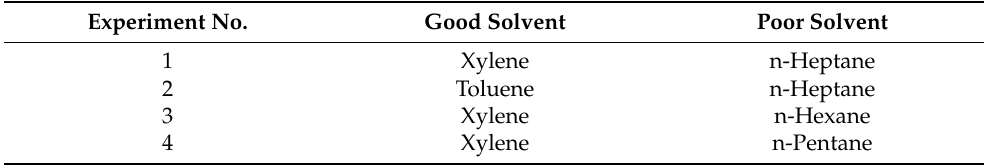
Table 1. The solvents used in four groups of experiments. Experiment No. Good Solvent Poor Solvent